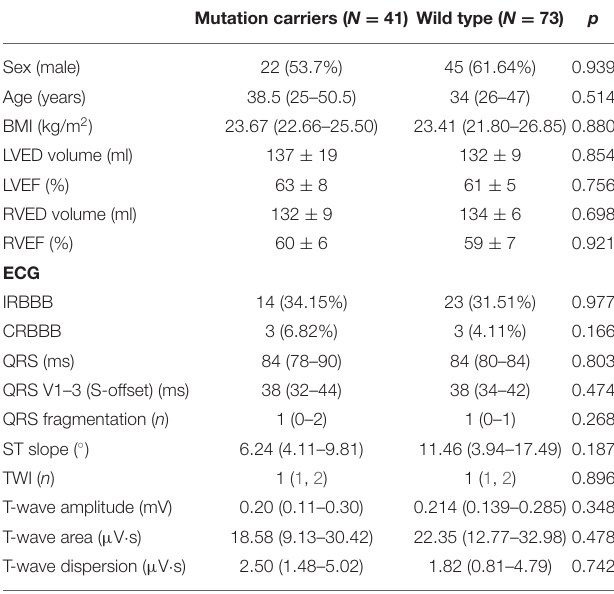
TABLE 2 | Quantitative analysis of the electrocardiographic parameters through digital analysis in gene carriers and wild-type